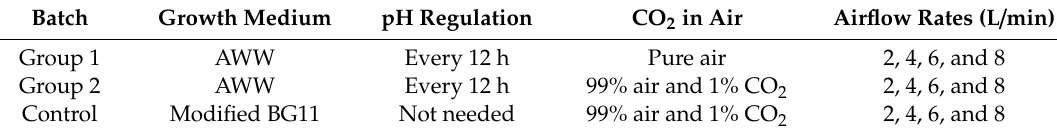
Table 1. Specifications of the two groups and the control treatment evaluated in the experiment.